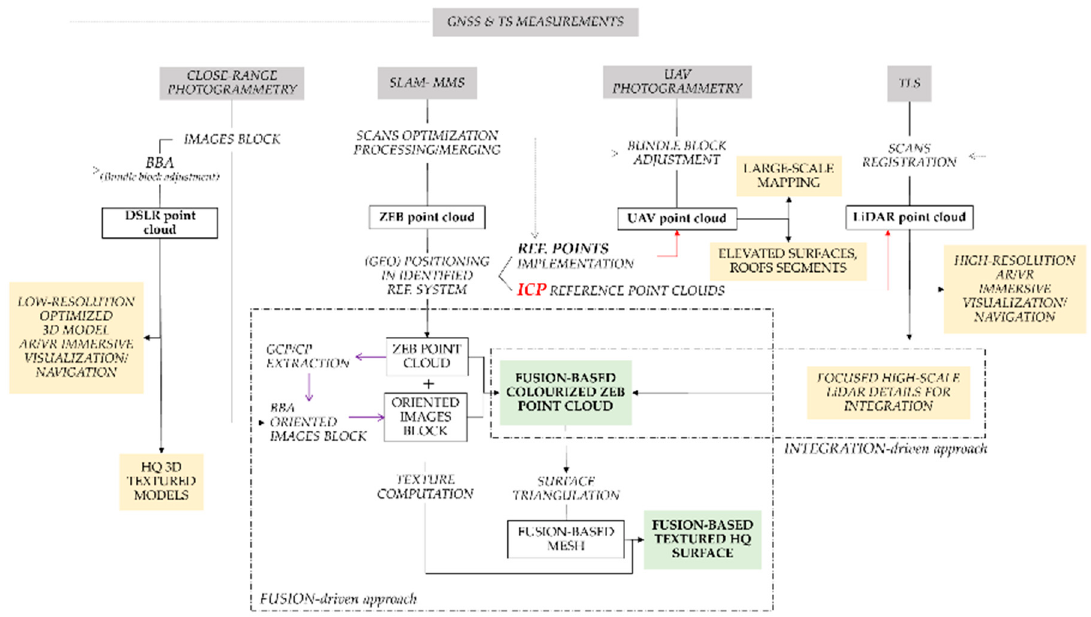
Figure 21. Graphic workflow of the hybridization of 3D models, deriving from integrated methods and fusion-based approaches. In grey, the acquisition methods, in green the achieved products with the possible connections. In the dashed box the fused and integrated results.